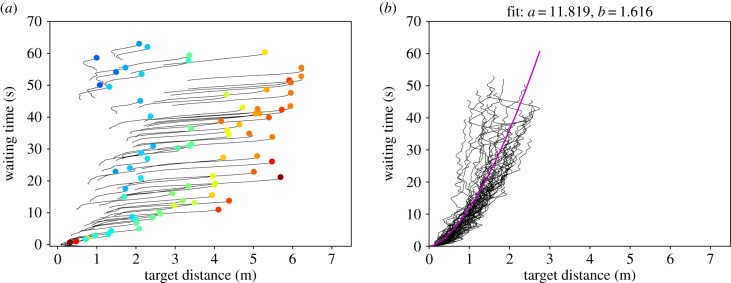
Two phases of the waiting time plots for Run 030. (a) Initial phase (0–5 s after the starting signal) and (b) congested phase (10 s after the starting signal).